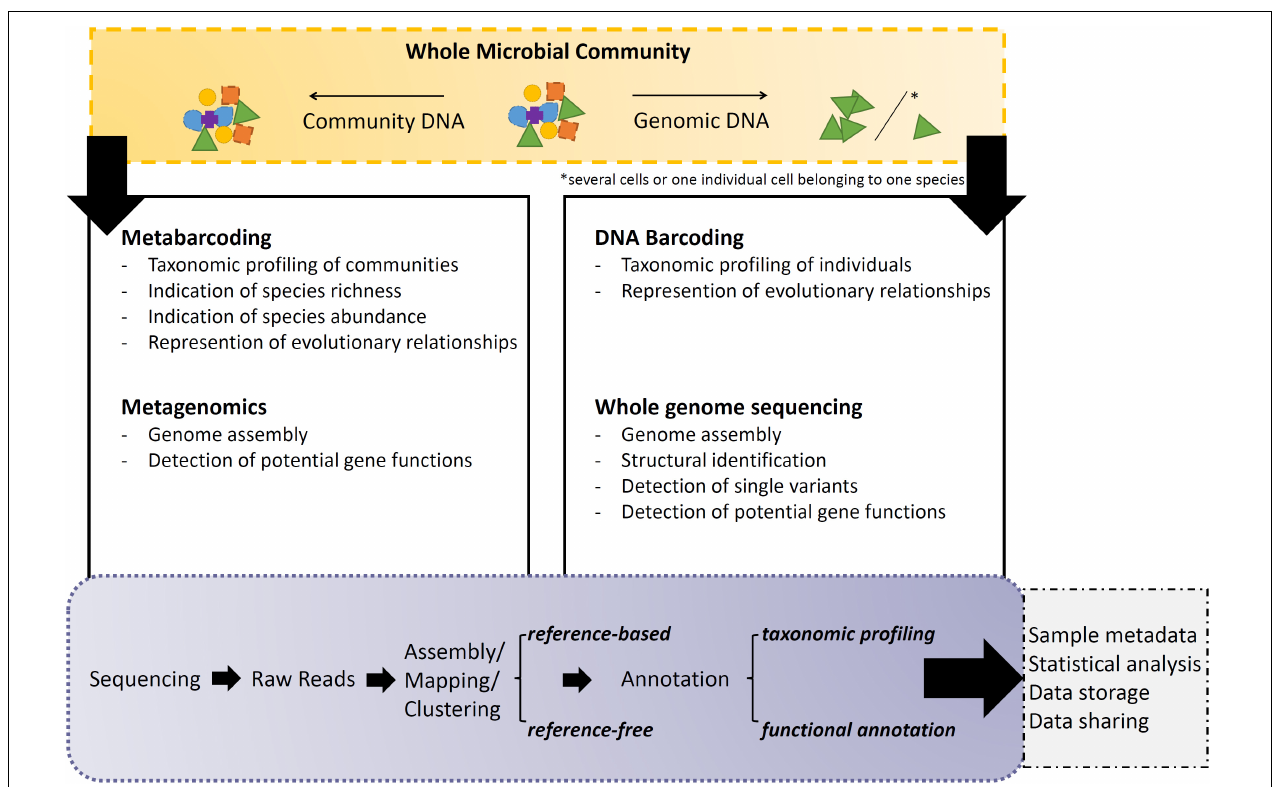
FIGURE 2 | Overall summary of the listed gen*omics applications and their major